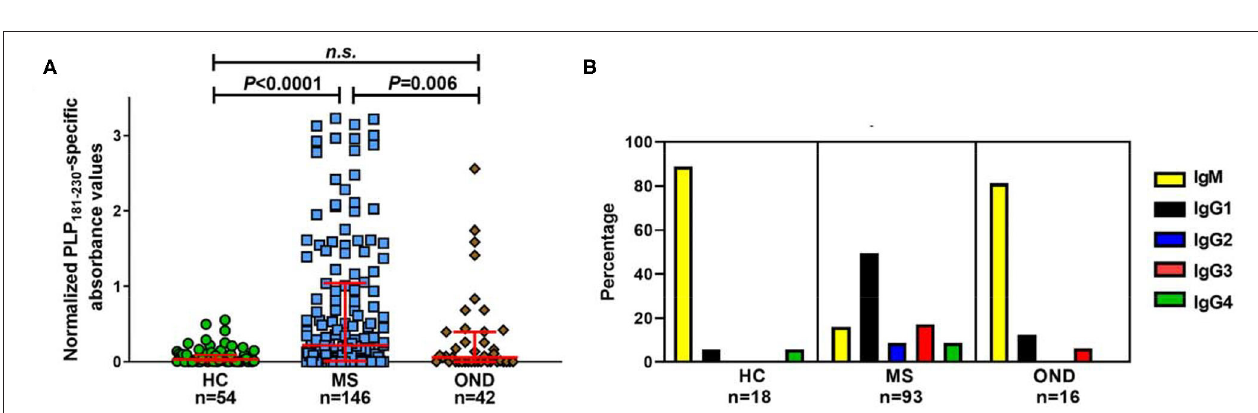
FIGURE 2 | Significantly elevated levels of isotype-switched anti-PLP antibodies are present in MS patients. (A) Reactivity in ELISA of healthy individuals’ (HC), MS and OND patients’ sera (all tested at 1/40 dilution) to PLP 181 − 230 , synthesized with 2 disulphide bonds to mimic the structure of the second extracellular loop of PLP. Results are presented as the normalized PLP 181 − 230 -specific absorbance values. Analyzed using Kruskal–Wallis test with Dunn’s multiple comparison test. (B) Percentage of samples of each isotype from individuals with elevated (at or above the 75th percentile of the HC group) antibodies reactive to PLP. n.s., not significant.